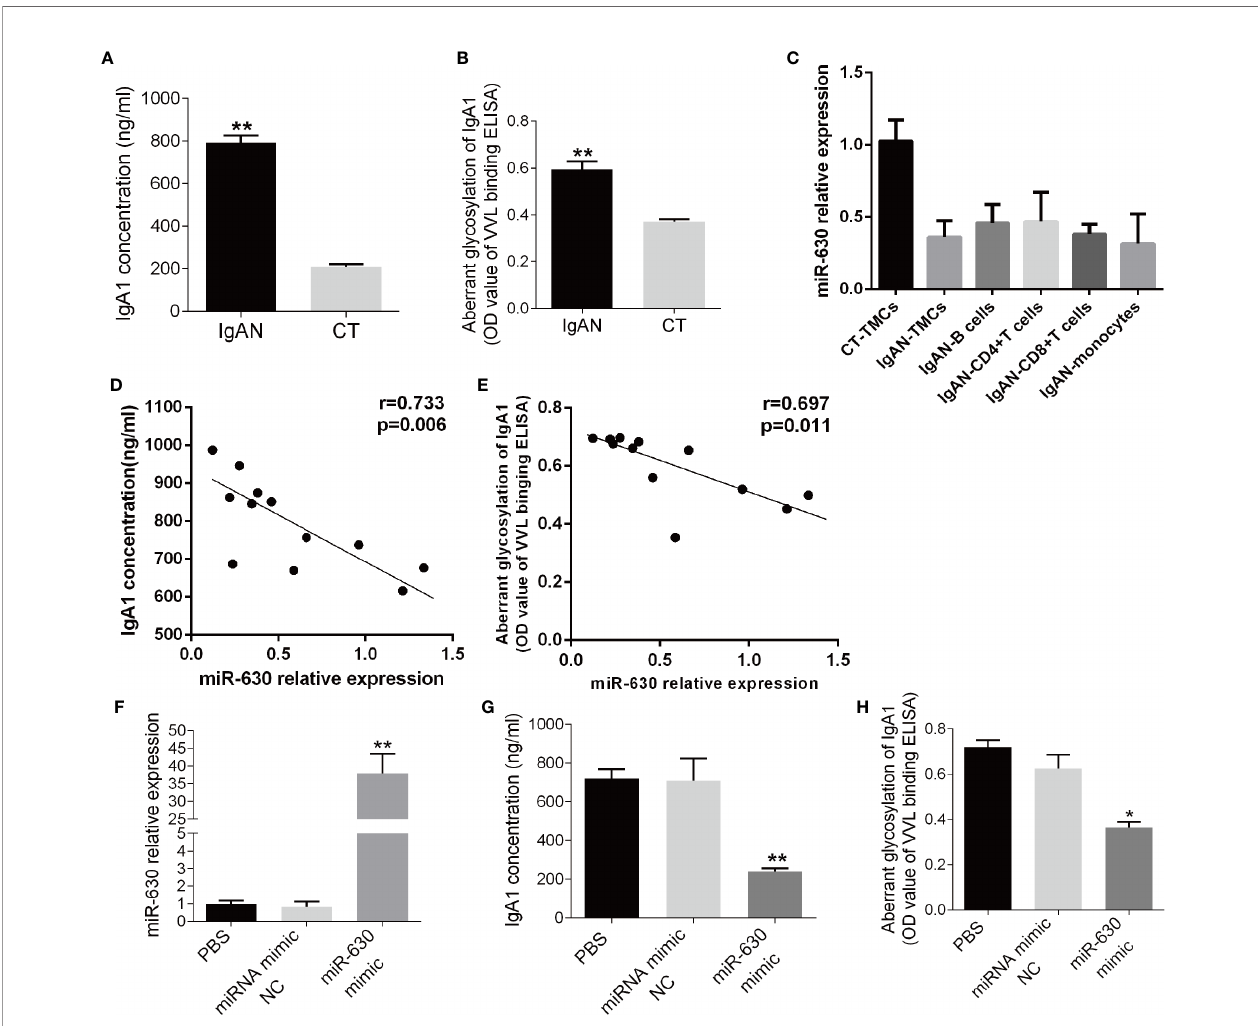
FIGURE 2 | miR-630 regulates the concentration and glycosylation level of IgA1. (A) ELISA detected the concentration of IgA1 in the supernatant of TMCs derived from IgAN and CT group, respectively. (B) The binding force of IgA1 with the broad bean lectin [IgA1- Vicia villosa lectin (VVL)-binding OD value] was measured by enzyme- linked lectin assay. (C) qRT-PCR detected the expression of miR-630 in different subtypes of mononuclear cells including CD4 + T cells, CD8 + T cells, pan B cells, and pan monocytes, which were isolated from TMCs by magnetic beads. (D, E) The correlation between the expression of miR-630 and the concentration of IgA1 as well as the binding force of IgA1 with the broad bean lectin in TMCs were analyzed by Pearson correlation analysis and linear regression analysis. (F) qRT-PCR showed that the expression of miR-630 was increased signi fi cantly in TMCs transfected with miR-630 mimics. (G, H) overexpression of miR-630 decreased the concentration of IgA1 and the binding force of IgA1 with the broad bean lectin in TMCs signi fi cantly. The data were expressed as mean ± SEM, **p < 0.01.*p < 0.05. IgAN, IgA nephropathy, N=27; CT, chronic tonsillitis, N=20. NC, negative